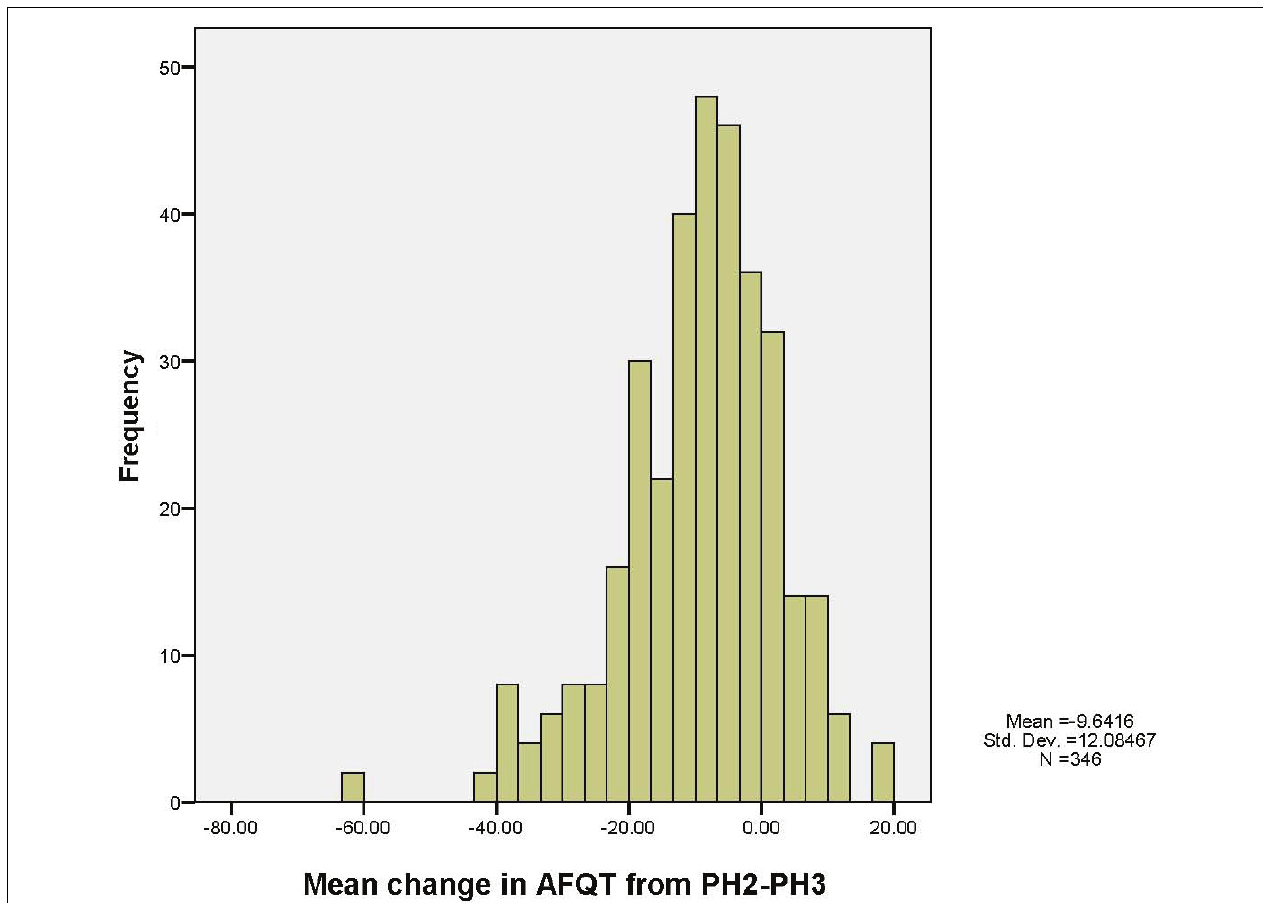
FIGURE 3 | Mean change inAFQT scores from Phase 2 to Phase 3 in subjects